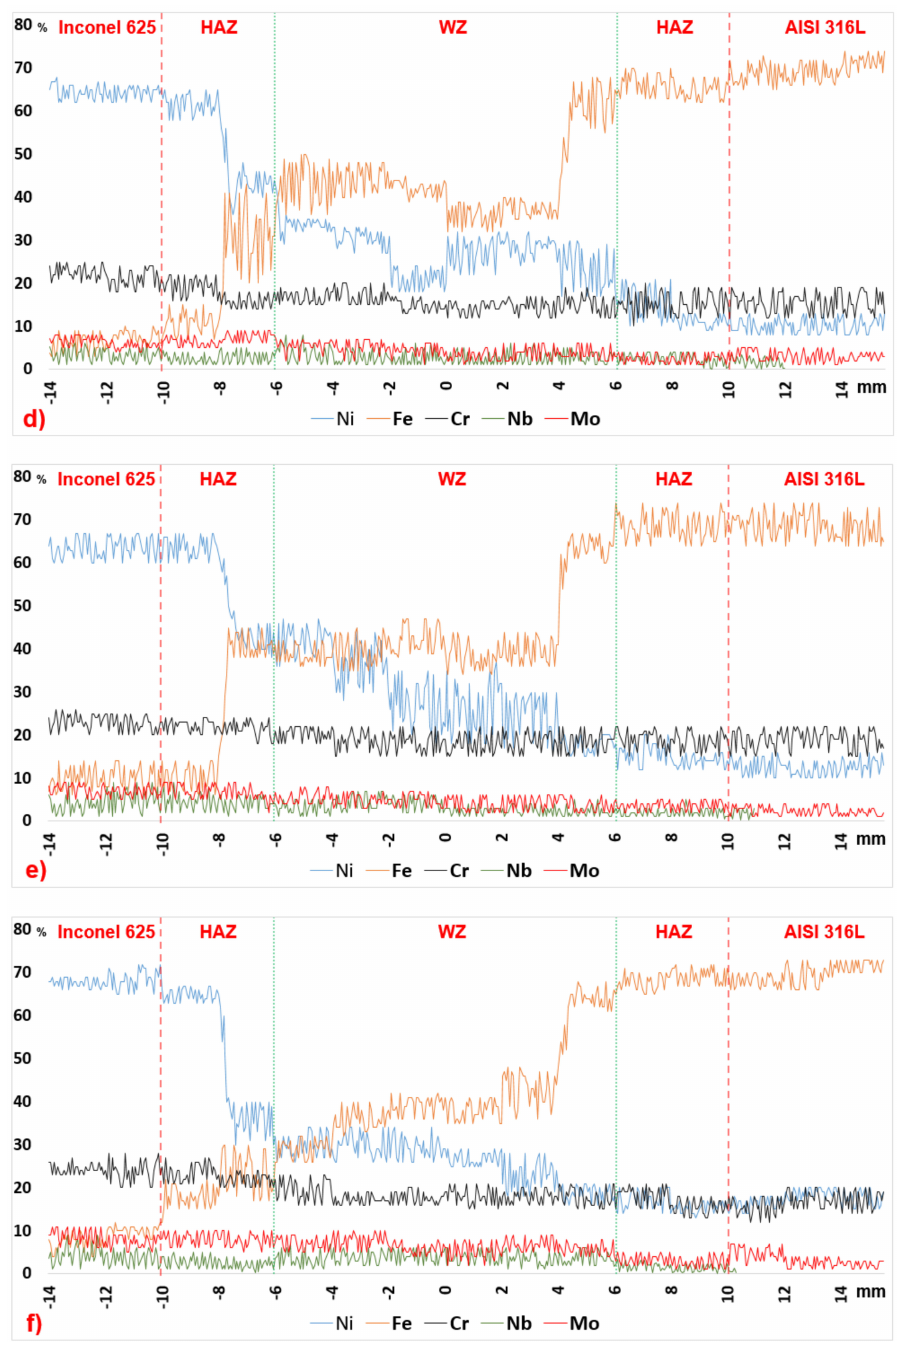
Figure 7. Line mapping analysis of bimetallic joints of Inconel 625 and AISI 316L obtained by PCGTA welding, employing ERNiCr3 ( d ), TIG 316L ( e ), Twisted Filler ( f